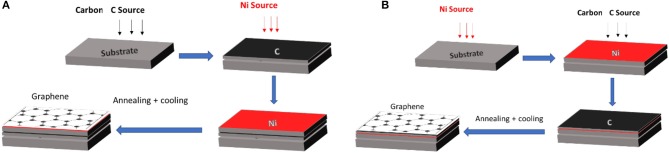
Different stacking orders using Ni on graphene growth (A) Sequence: Ni/a-C/substrate. (B) Sequence: a-C/ Ni/substrate.